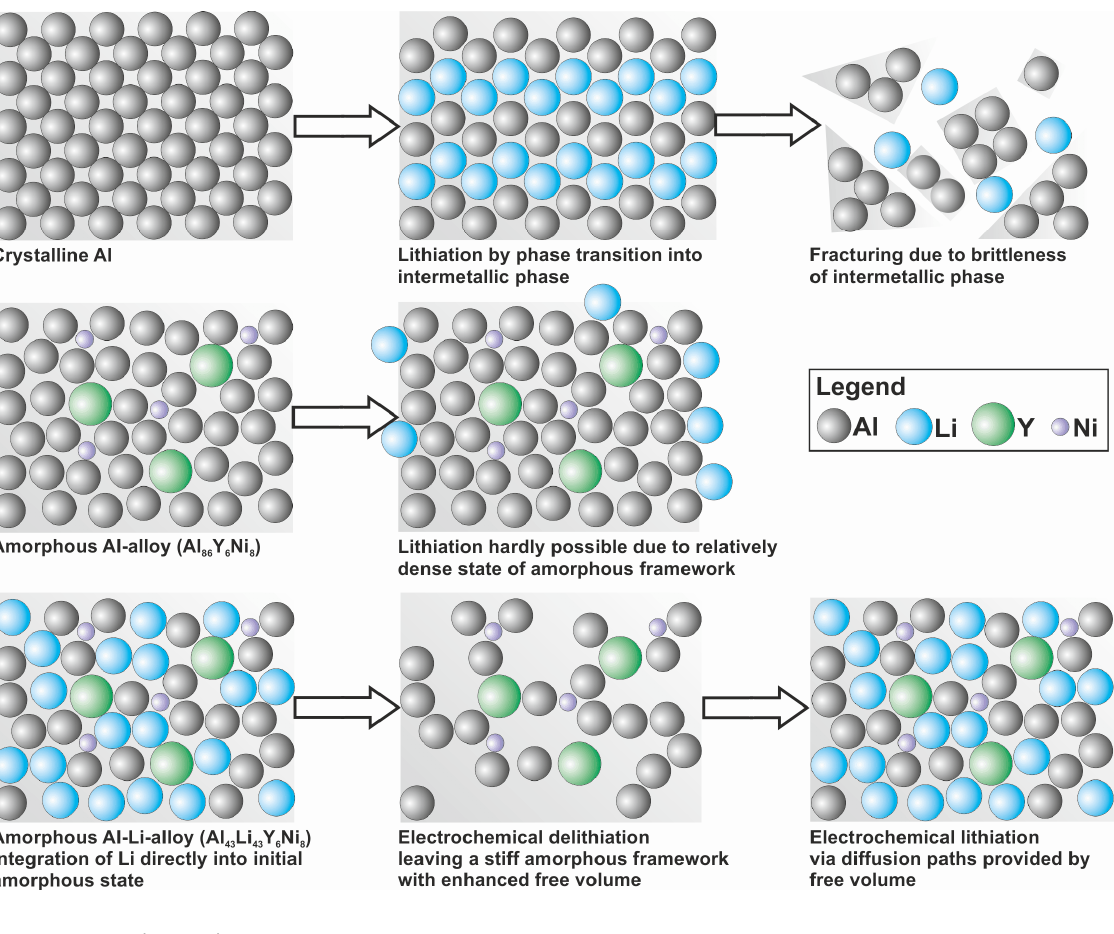
Li Y Ni ( lower row 43 43 6 8